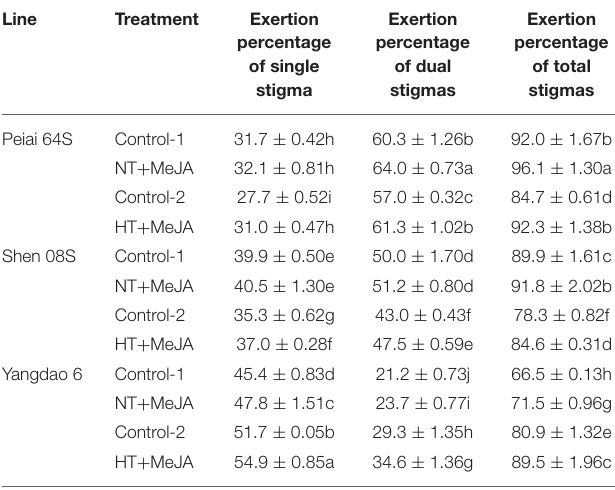
Control-1 and Control-2 indicate spraying water under normal temperature (NT) and spraying water under high temperature (HT), respectively. NT + MeJA and HT + MeJA represent spraying MeJA under NT and spraying MeJA under HT, respectively. Data are expressed as the mean ± SD (n = 18). Different letters indicate significant difference at the P ≤ 0.05 level within the same column.